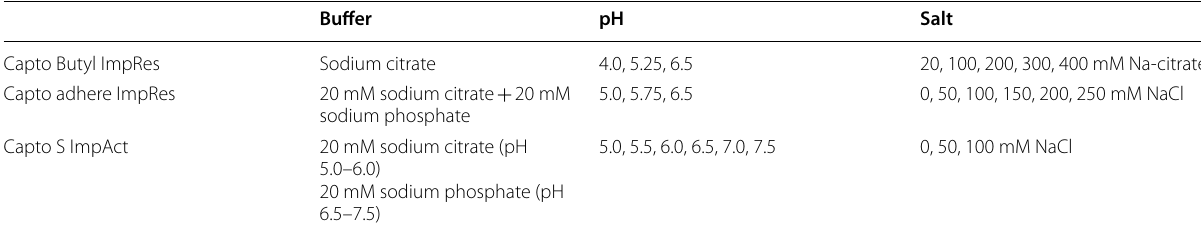
Table 2 96-well plate screening conditions of Capto Butyl ImpRes, Capto adhere ImpRes and Capto S ImpAct for both FabscFv-KiH and Fab scFv-KiH 2